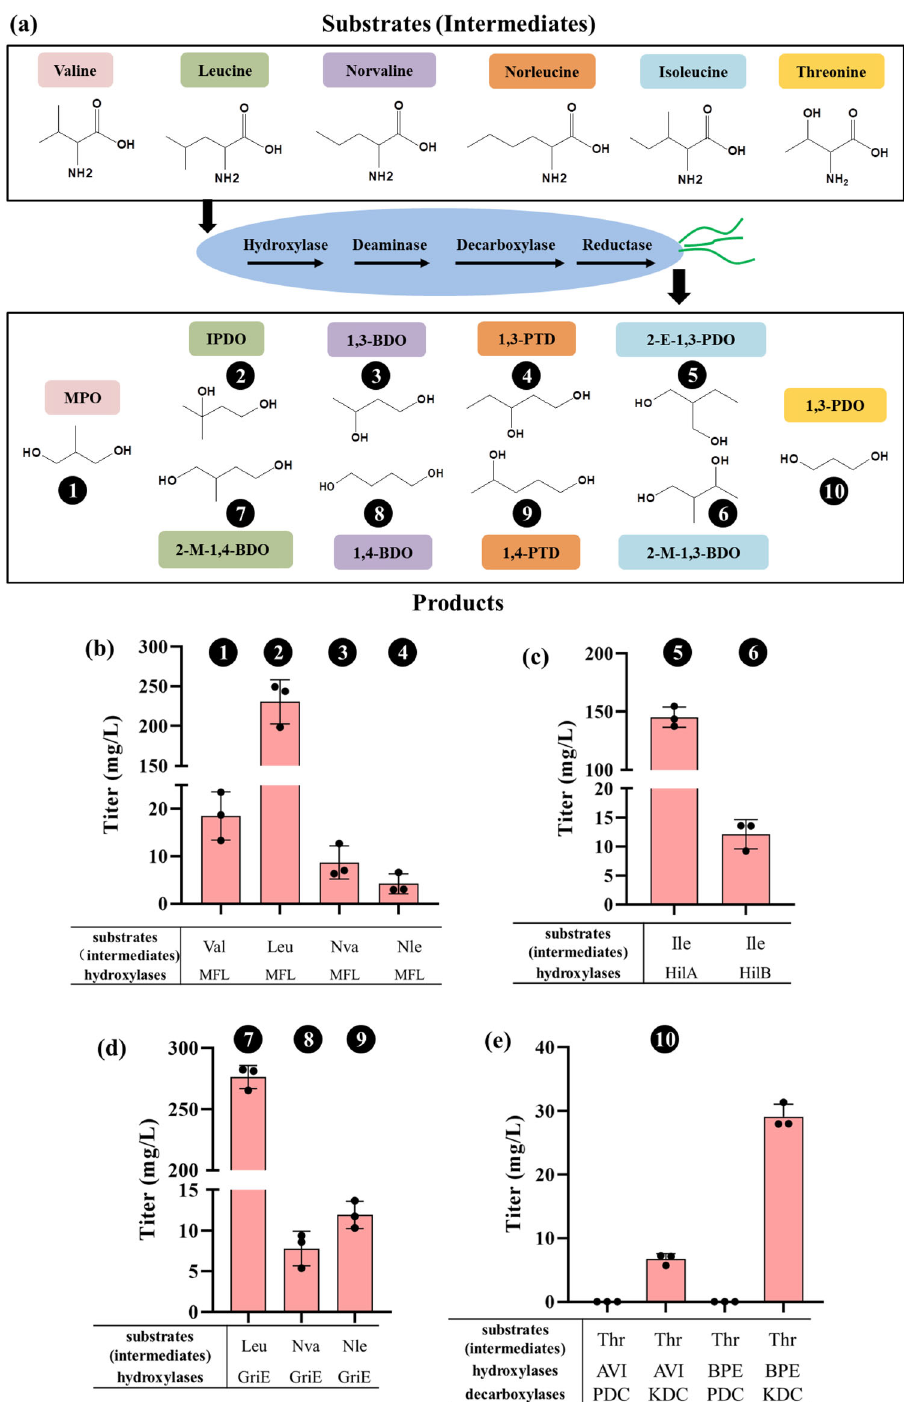
Fig. 2 Details of the platform pathway for the production of 10 structurally diverse diols. The substrate (intermediate) amino acids used and their corresponding diol products are highlighted by the same colors ( a ); b – e production titers of diols. The numbers representing each diol are in line with those in a . MPO 2-methyl-1,3-propanediol, IPDO isopentyldiol, 1,3-BDO 1,3-butanediol, 1,3-PTD 1,3-pentanediol, 2-E-1,3-PDO 2-ethyl-1,3-propanediol, 2-M-1,3-BDO 2-Methyl-1,3-butanediol 2-M-1,4-BDO 2-Methyl-1,4-butanediol, 1,4-BDO 1,4-butanediol, 1,4-PTD 1,4-pentanediol, 1,3-PDO 1,3-propanediol, Val valine, Leu leucine, Ile isoleucine. Nva norvaline, Nle norleucine, Thr threonine. b – e the average and standard deviation (s.d.) of three biologically independent experiments are shown. Source data are provided as a Source Data fi